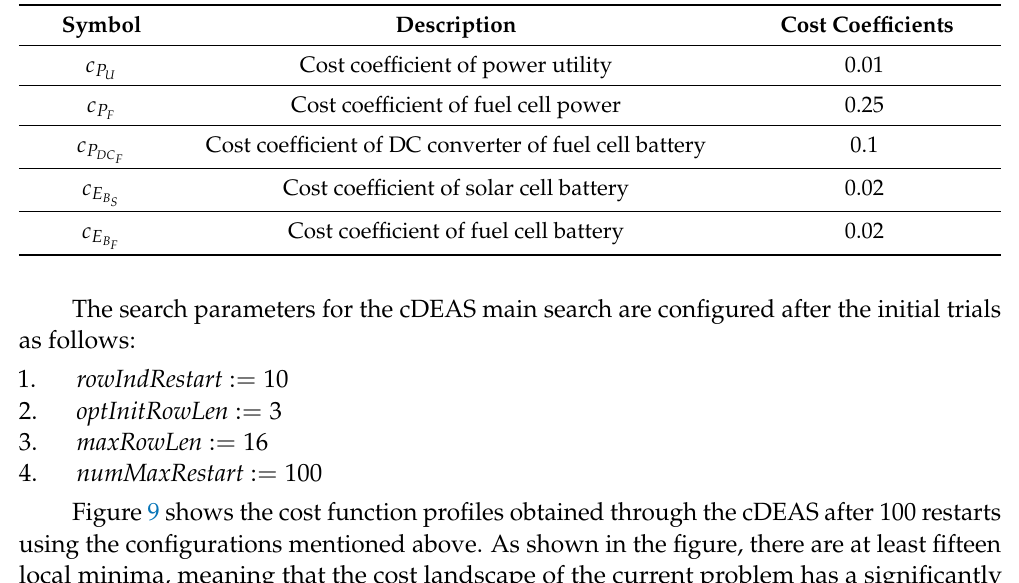
Table 2. List of element cost coefficients.